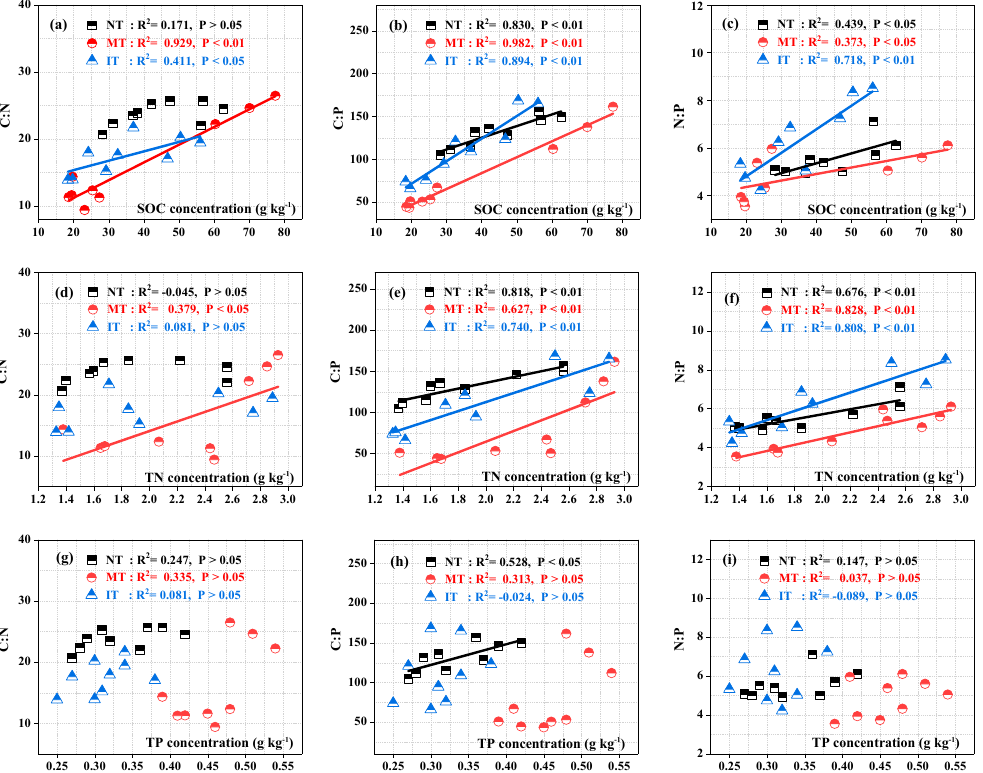
Figure 5. Linear regressions of the relationships between contents of soil organic carbon (SOC) ( a – c ), total nitrogen (TN) ( d – f ), and total phosphorus (TP) ( g – i ), as well as their stoichiometry in the no-thinning control (CK), moderate thinning (MT), and heavy thinning (IT), respectively. Straight lines correspond to significant relationships. Abbreviations: C:N, SOC–to–TN ratio; C:P, SOC–to–TP ratio; N:P, soil TN–to–TP ratio.